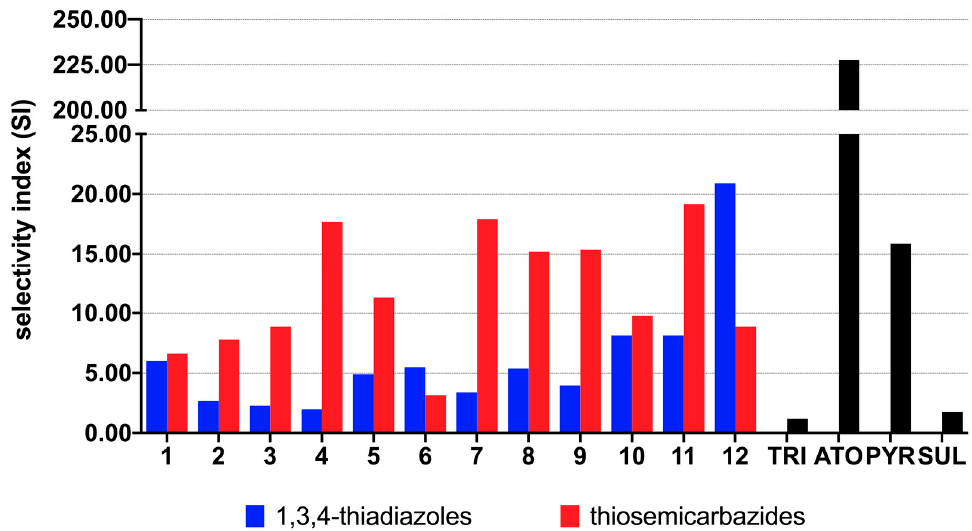
Figure 4. Selectivity index (SI) for the 1,3,4-thiadiazoles 1b – 12b and the thiosemicarbazides 1a–12a calculated as the ratio of CC 30 to IC 50 . Reference drugs: TRI—trimethoprim, ATO—atovaquone, PYR—pyrimethamine, SUL—sulfadiazine.